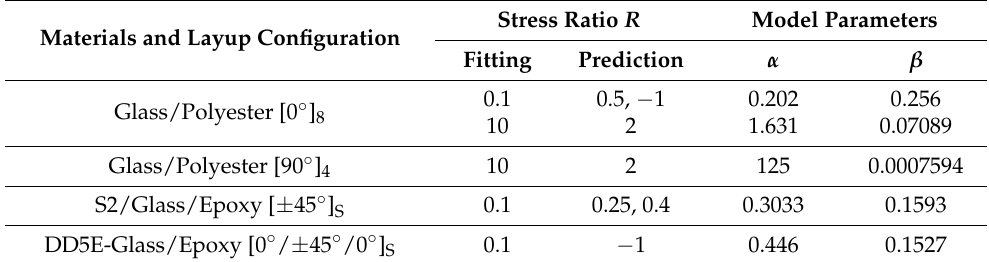
Table 4. Determination of model parameters considering stress ratio effect.